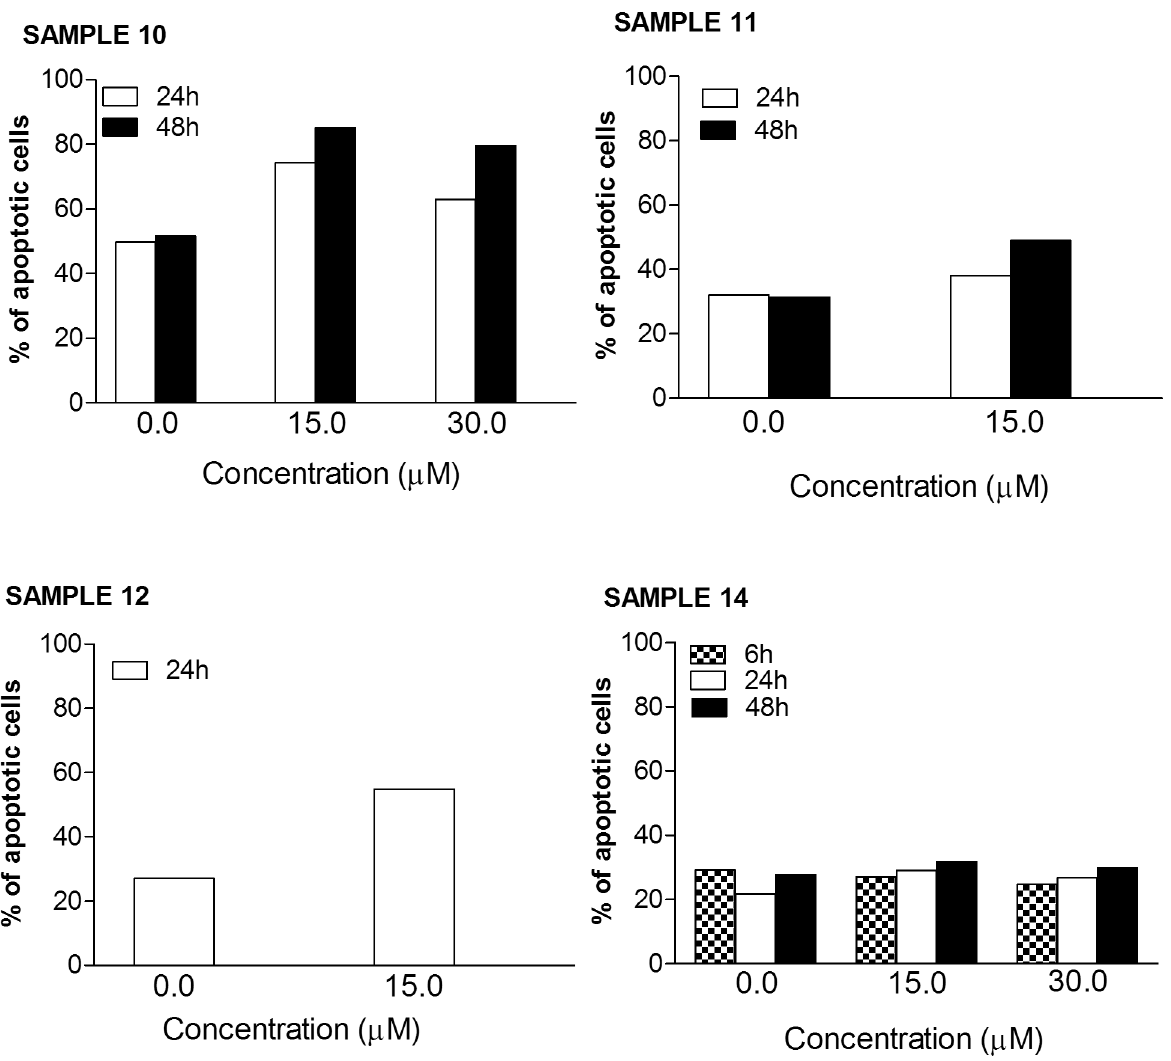
Figure 3. Fraction of apoptotic cells induced by SR on mononuclear cells isolated from ALL and BNKAL patients. Cells were treated with 0 to 30 m M SR for 6, 24 or 48 h.